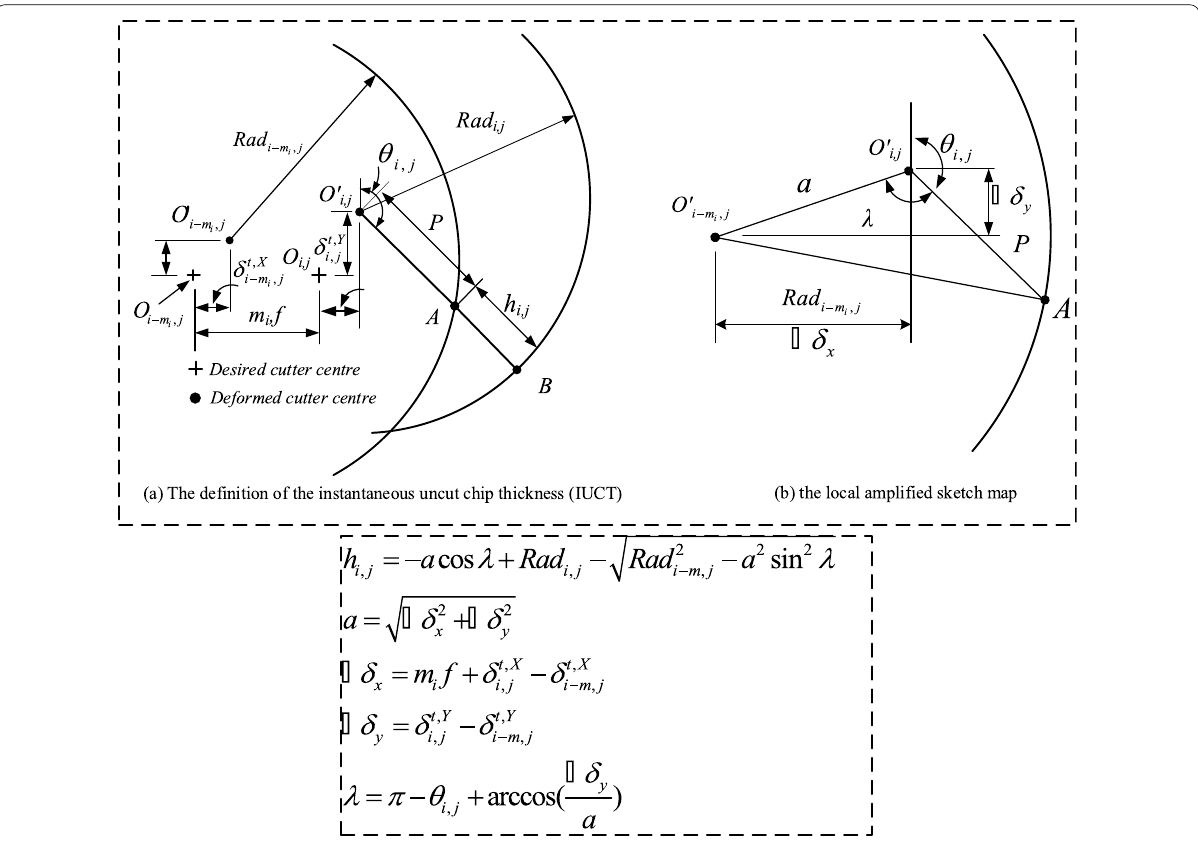
Figure 14 Geometric illustration of the instantaneous uncut chip